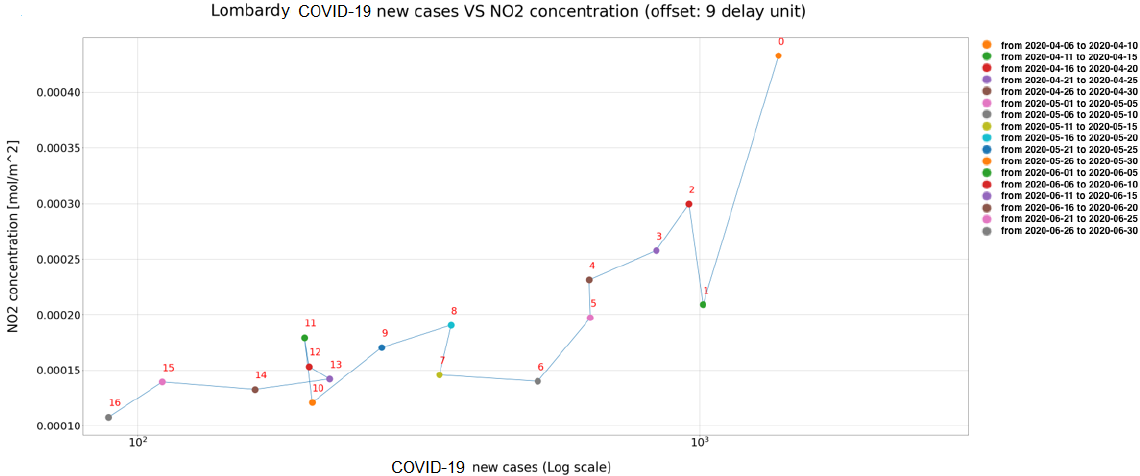
Figure 15. New daily cases vs. average concentration of NO 2 in Lombardy.